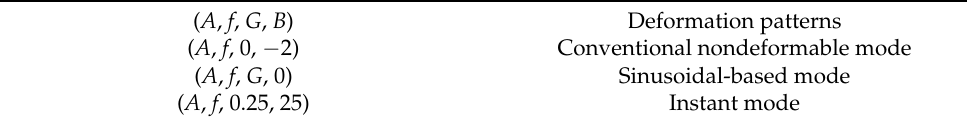
Table 1. Three deformation patterns of the caudal